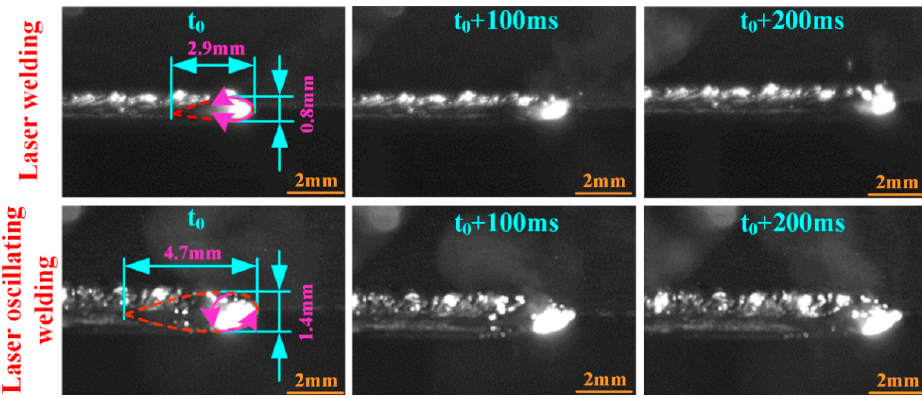
Figure 7. Images of the molten pool under different welding modes.